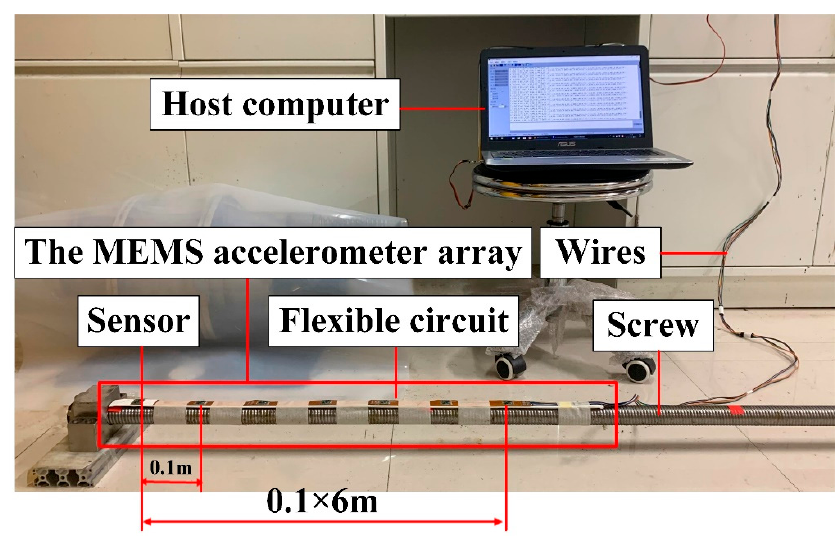
Figure 8. The Micro-Electro-Mechanical Systems (MEMS) accelerometer array.